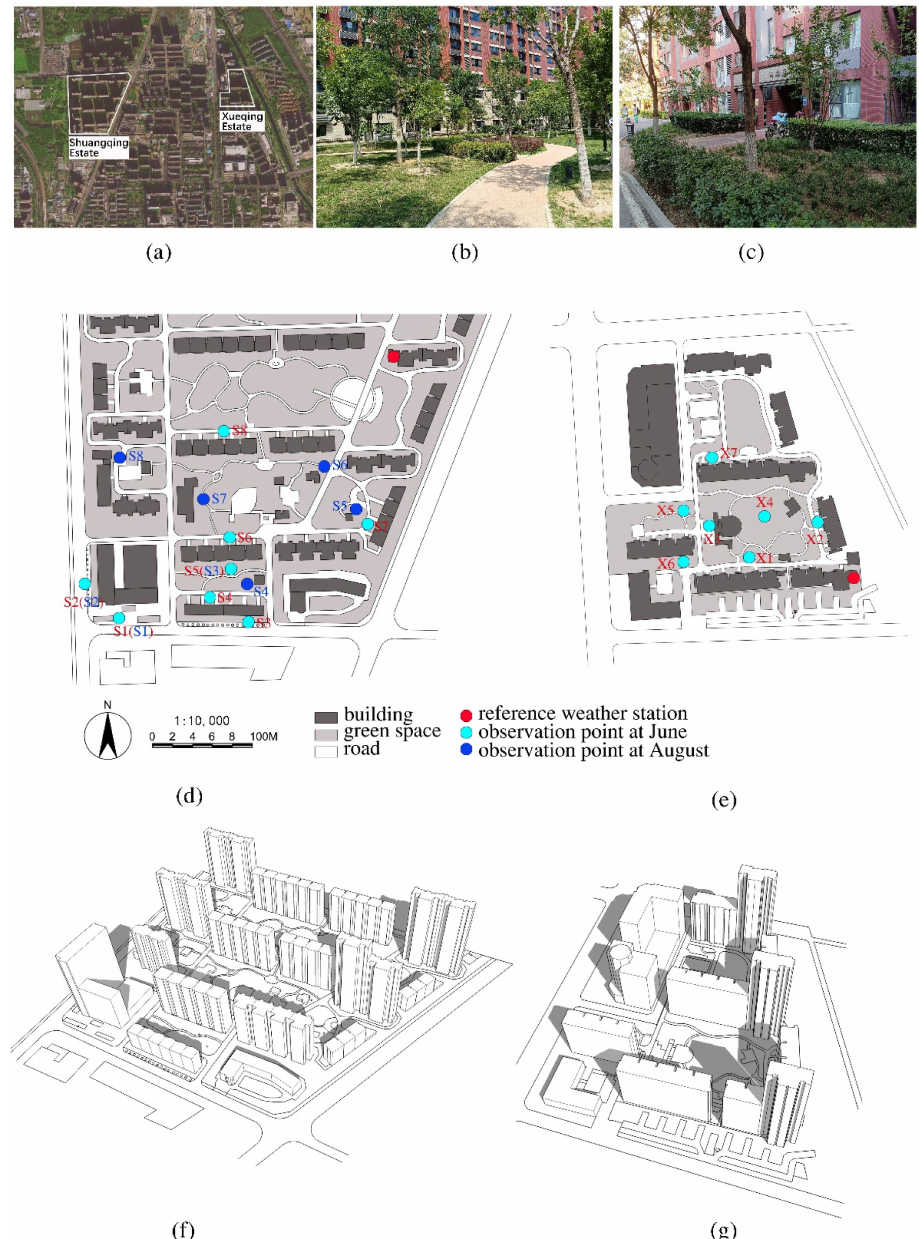
Figure 4. Location of the two residential estates ( a ), the actual view of Shuangqing Estate ( b ), the actual view of Xueqing Estate ( c ), general plans and observation points of Shuangqing Estate ( d ), general plans and observation points of Xueqing Estate ( e ), aerial view of Shuangqing Estate ( f ), aerial view of Xueqing Estate ( g